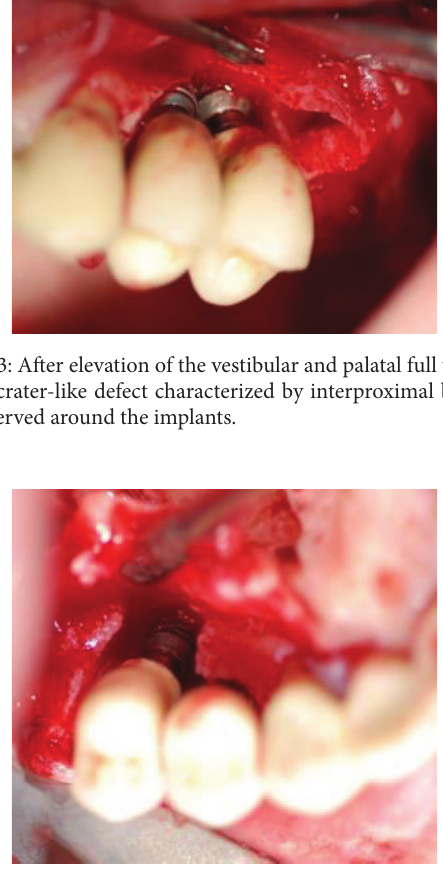
Figure 4: After elevation of the vestibular and palatal full thickness flaps, a crater-like defect characterized by interproximal bone loss was observed around the